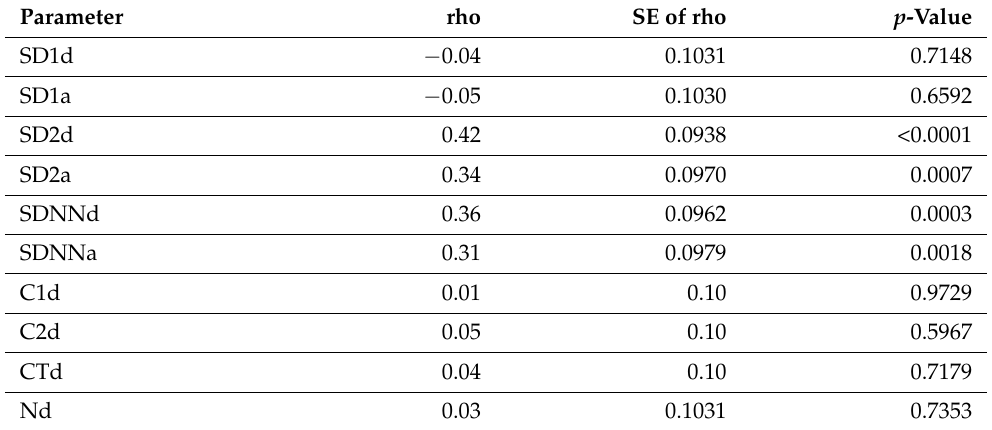
Table 3. The correlation between age and continuous HRA descriptors (n = 96) (Spearman’s rank correlation